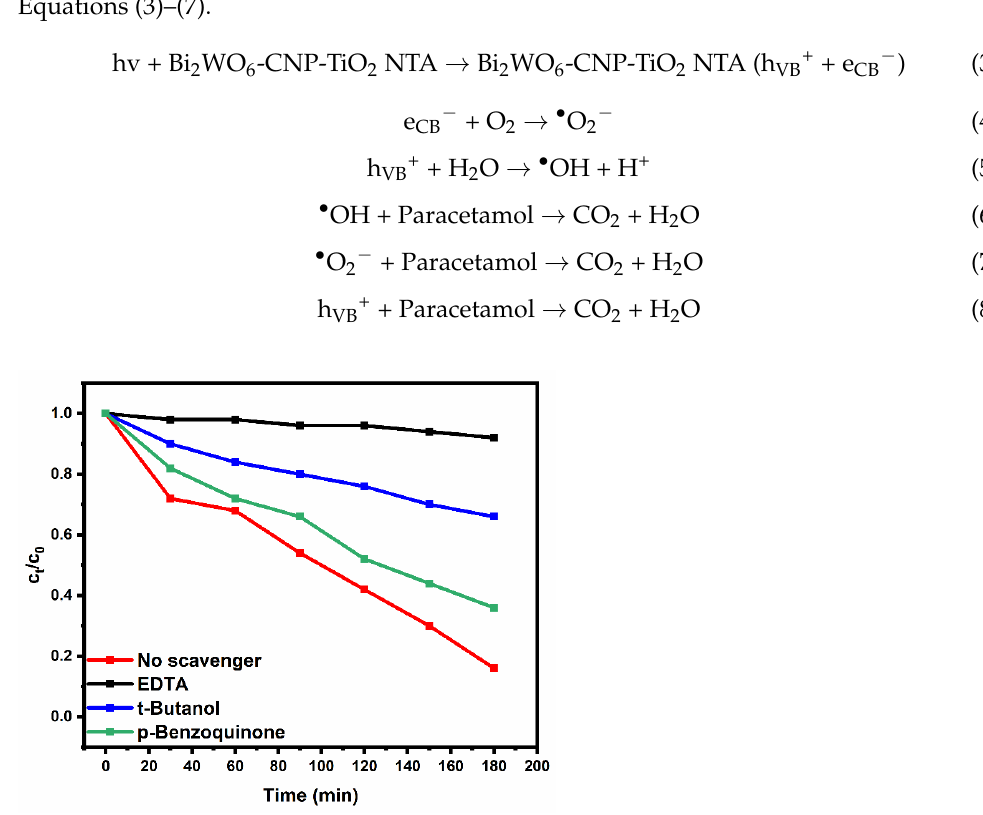
Figure 5. Scavenger studies of the photoelectrocatalytic degradation of Paracetamol on Bi 2 WO 6 -CNP-TiO 2 NTA.